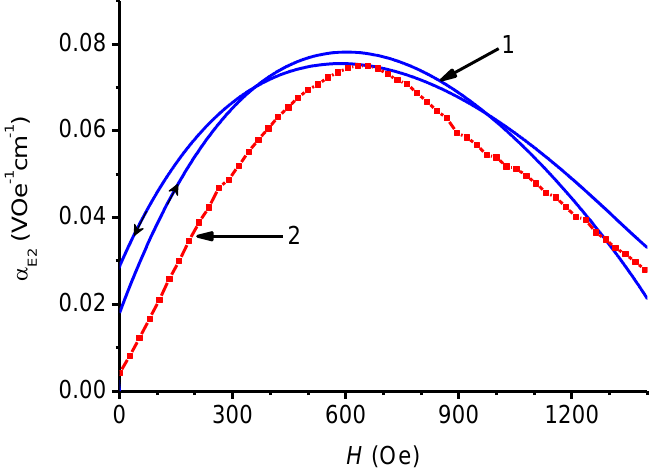
Figure 6. Dependence of the ME interaction efficiency α CoFe/PZT structure obtained by the pulse method (1) and by the HFM method at f = 1 kHz (2). The arrows indicate the variation of magnetic field strength H with time. The line connecting the experimental points in curve 2 serves as a guide to the eye.